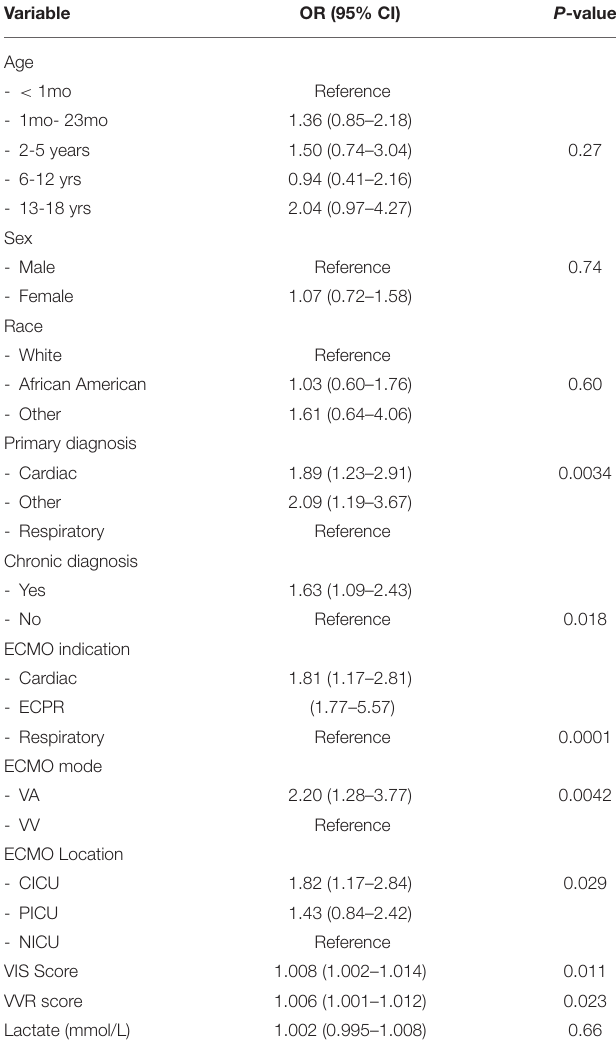
TABLE 2 | Association of predictor variables with mortality by univariable